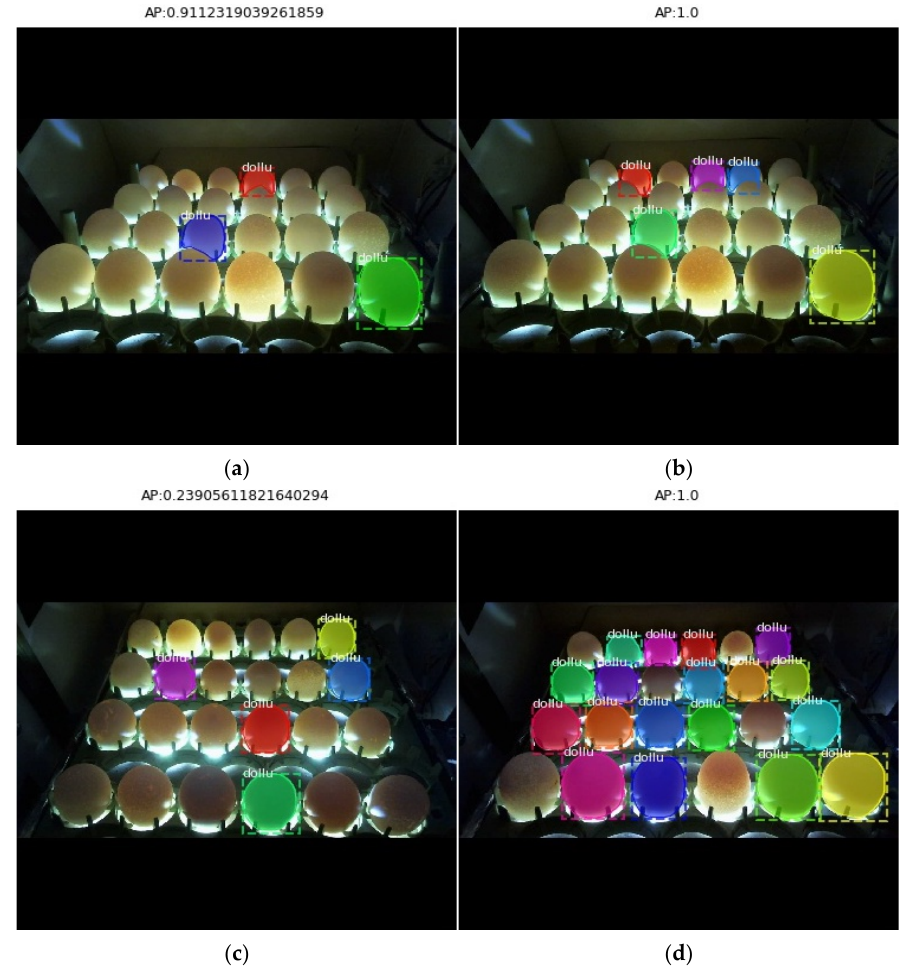
Figure 7. Images resulting from the test process (( a , b ) first dataset—( c , d ) second dataset).